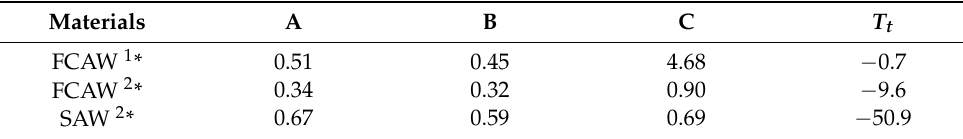
Figure 8. Comparison of ductile to brittle transition behavior according to test method.